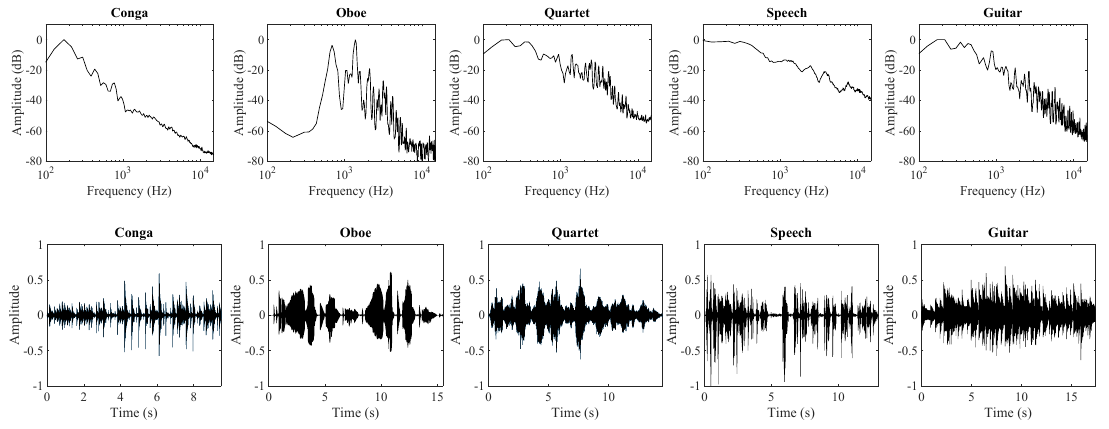
Figure 2. Long ‐ term average spectra and waveforms of test stimuli used for Experiment One.